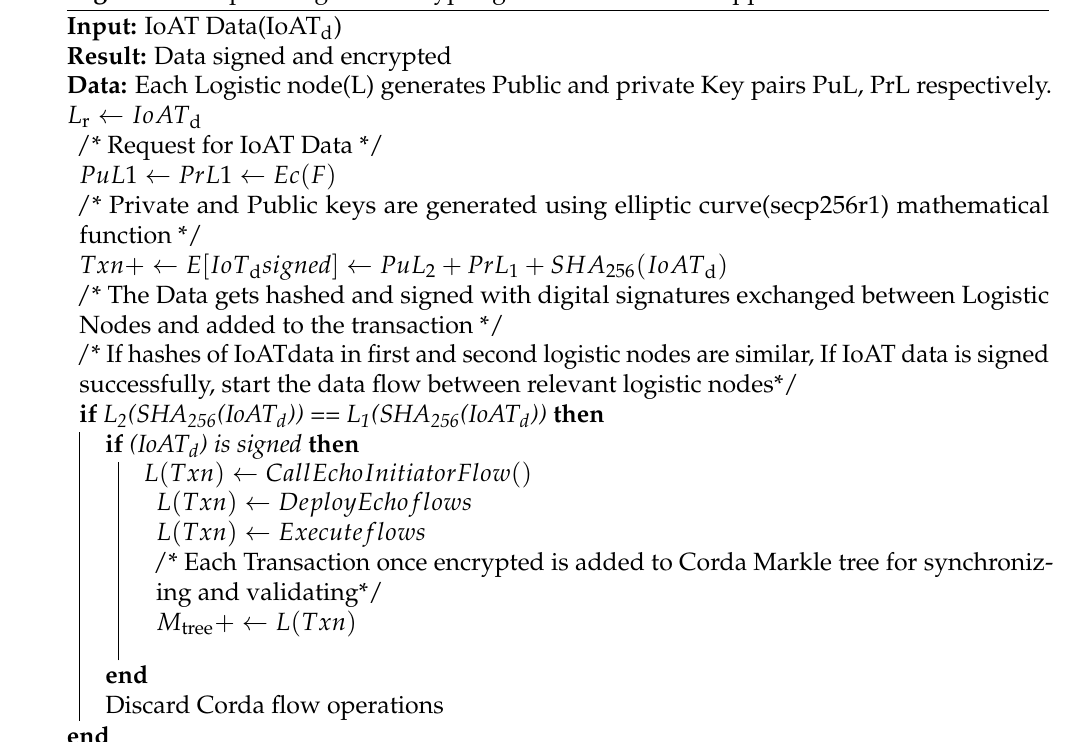
Algorithm 1 Uploading and Encrypting IoAT Data in CorDapp.